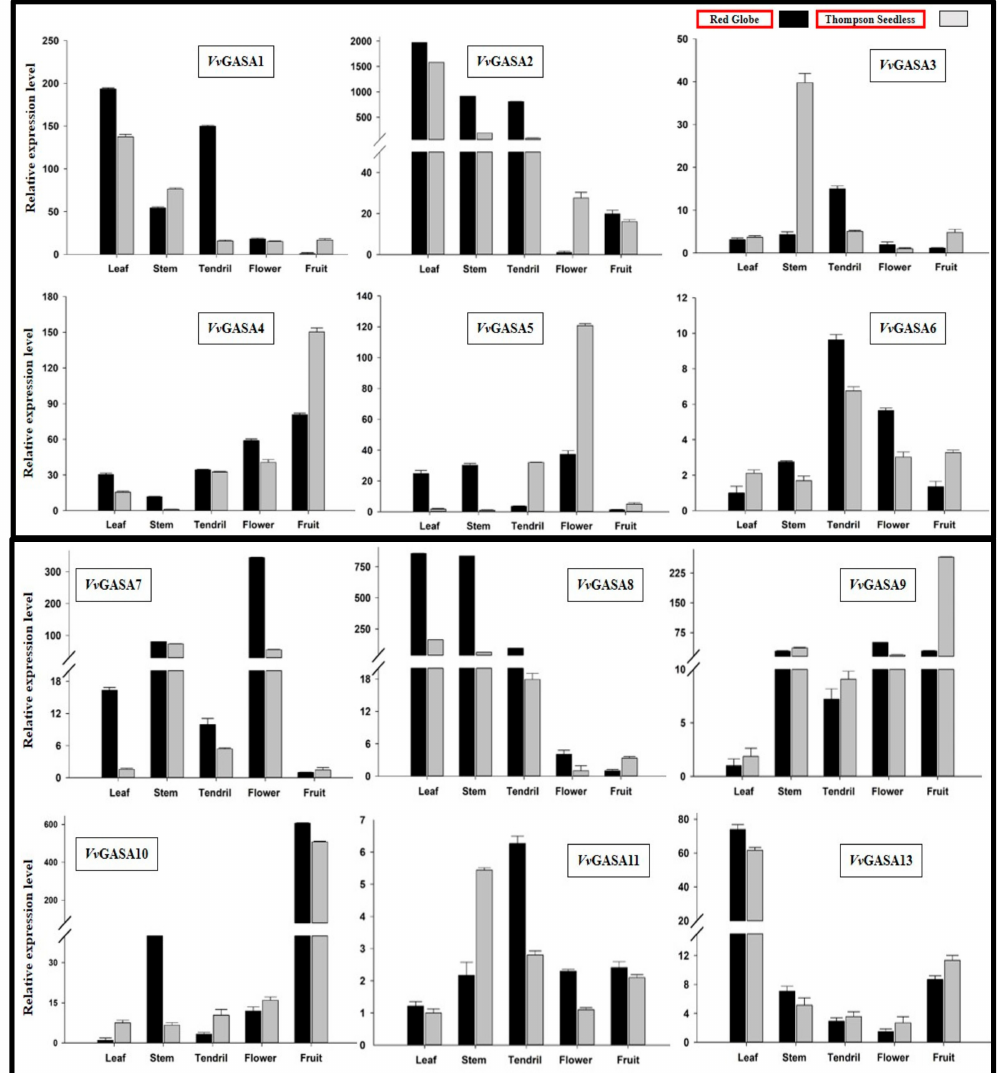
Figure 6. Real-time PCR analysis of di ff erent plant